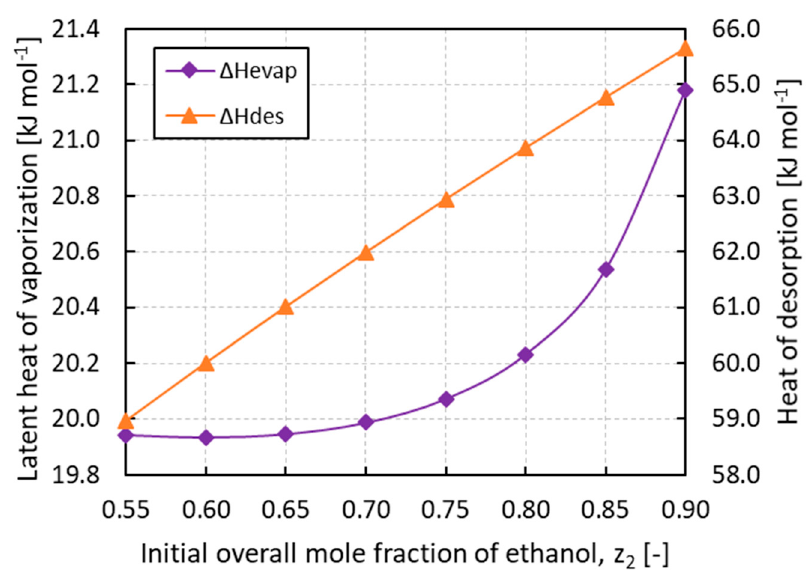
Figure 8. Latent heat of vaporization ( ∆ H evap ) and heat of desorption ( ∆ H des ) of ammonia / ethanol mixture vs. the initial overall mole fraction of ethanol z 2 .